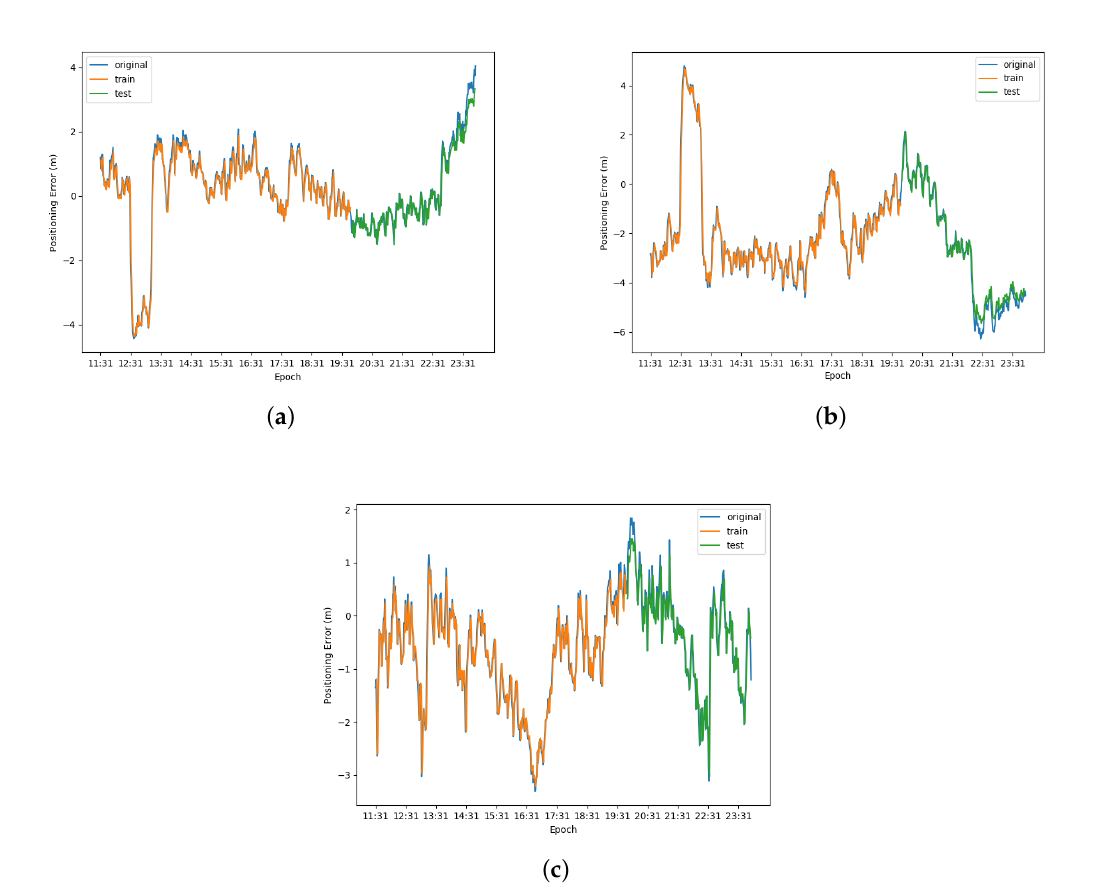
Figure 11. Result of LSTM error prediction performed on Kalman filter: ( a ) result on X-axis; ( b ) result on Y-axis; and ( c ) result on